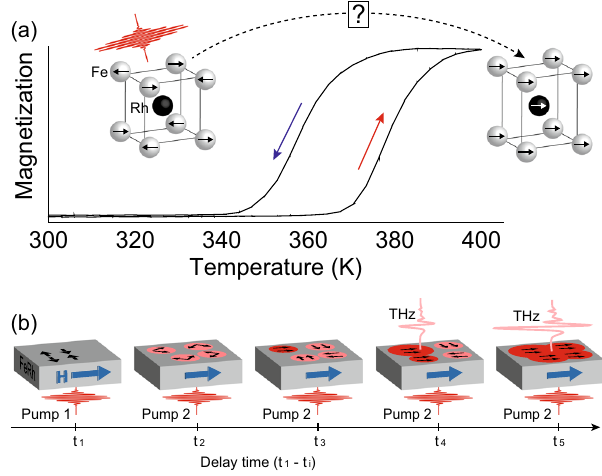
Fig. 1 First-order phase transition and double-pump THz emission in FeRh. a The temperature hysteresis of the FeRh magnetization measured by vibrating sample magnetometry 12 shows a characteristic fi rst-order phase transition. b The timeline of the laser-induced antiferromagnetic- ferromagnetic phase transition in FeRh under an applied magnetic fi eld μ 0 H and the principle of the double-pump THz emission spectroscopy. The initial pump (1) launches the phase transition at t 1 . The subsequent pump (2) arrives at t i ( i = 2, 3, … ) triggering THz emission from the ferromagnetic nuclei aligned along the magnetic fi eld. The intensity of the THz emission increases with the growing ferromagnetic nuclei with their magnetization along the applied magnetic fi